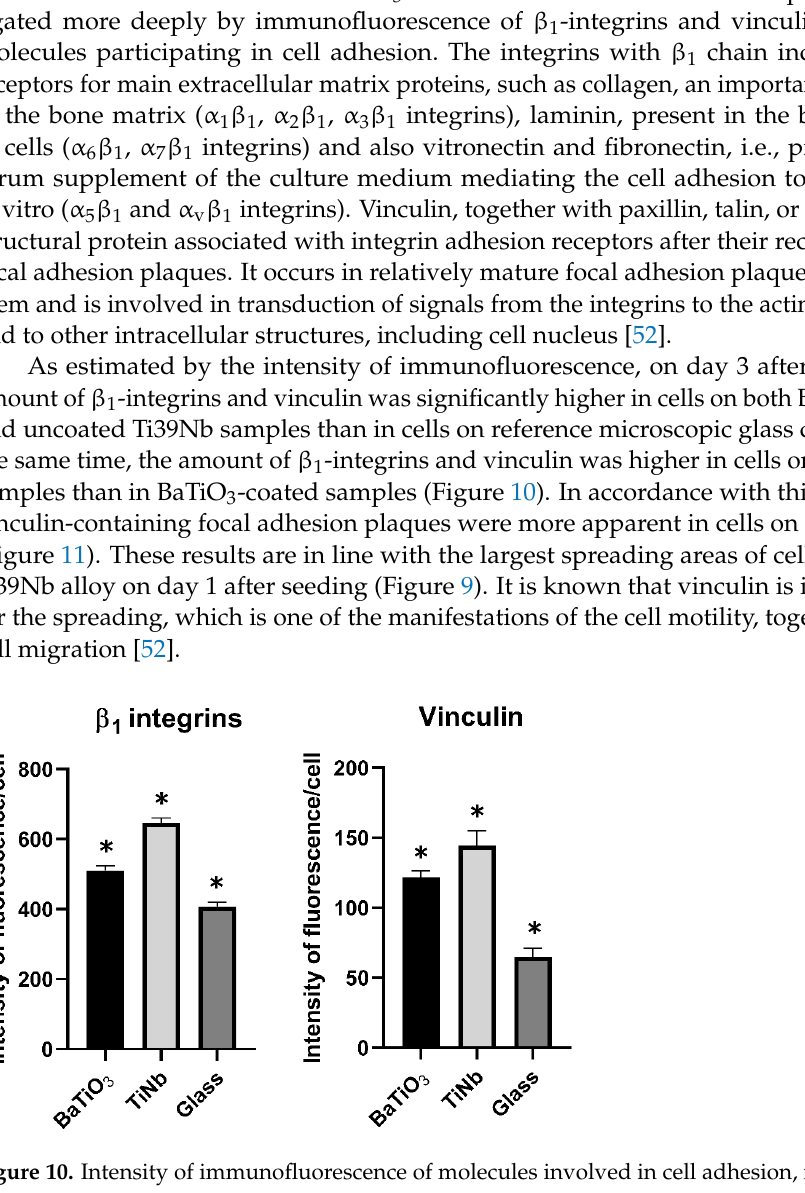
Figure 11. Immunofluorescence staining of vinculin ( green ), F-actin cytoskeleton ( red ), and nuclei ( blue ) in osteoblast-like Saos-2 cells on day 3 after seeding on Ti39Nb alloy coated with BaTiO 3 (BaTiO 3 ), bare Ti39Nb alloy (TiNb), and control microscopic glass coverslip (Glass). Bar = 100 µm. On day 7, markers of osteogenic differentiation, namely ALP, i.e., an enzyme in- volved in the bone matrix mineralization, and collagen I, a major component of the bone matrix, were also evaluated by measuring the intensity of immunofluorescence. The re- sults were similar as for the markers of cell adhesion — the amount of both differentiation markers was higher in cells on both coated and uncoated Ti39Nb samples than in cells on reference glass coverslips. At the same time, the amount of ALP was similar in cells on both coated and uncoated samples, but the amount of collagen I was significantly higher in cells on bare Ti39Nb than on BaTiO 3 -coated samples (Figure 12). This result was rather surprising, because earlier studies reported a positive effect of ferroelectric BaTiO 3 on os- teogenic cell differentiation. For example, in our earlier study, the intensity of fluorescence of ALP and osteocalcin, another marker of osteogenic cell differentiation, was significantly higher in Saos-2 cells on ferroelectric than on non-ferroelectric BaTiO 3 prepared on silica